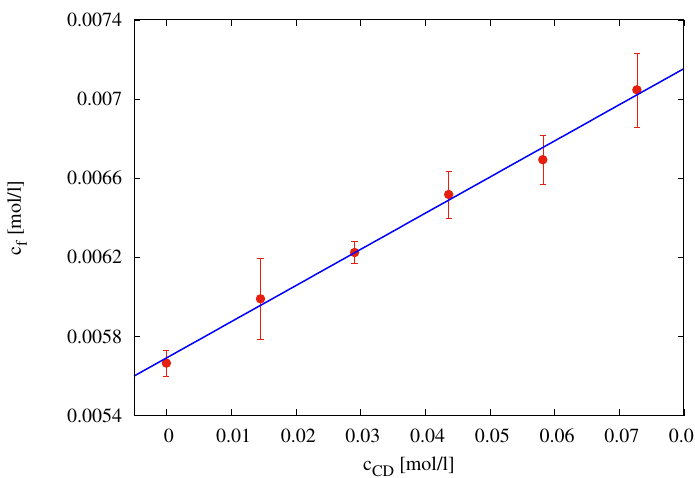
Figure 5. Phase solubility diagram of furosemide with HP- β -CD in simulated saliva (pH = 6.7) at T = 37 ◦